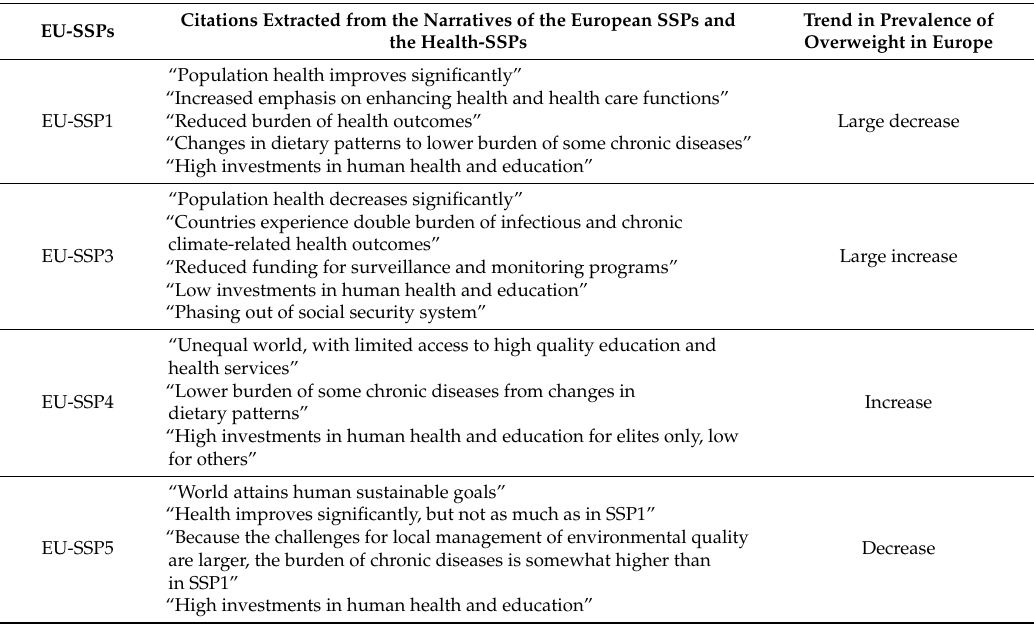
Table 4. Trends in future prevalence of overweight in Europe under each European SSP (EU-SSPs), based on the interpretation of the existing EU-SSPs [59] and extended SSPs for health (the latest version of the extended SSP for health [46] were not yet available when this research was conducted, so the preliminary version [45] was used instead).